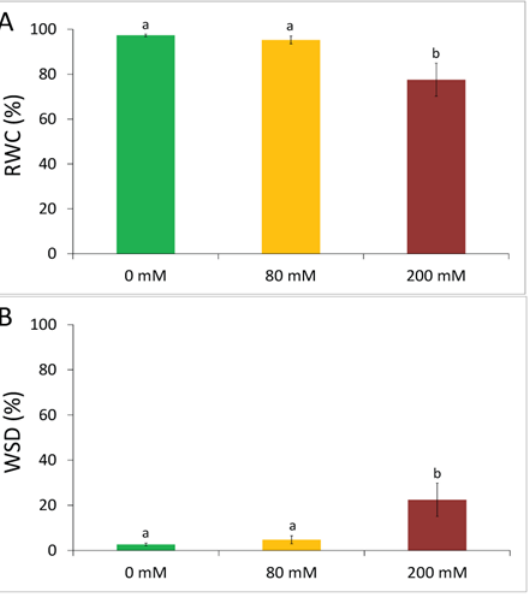
Figure 1. Relative water content (RWC: A ) and water saturation deficit (WSD: B ) recorded in Arundo donax leaves after 1 month of alkaline salt treatment. Error bars represent SD values. To compare the differences, one-way ANOVA was performed on each dataset combined with Tukey’s post-hoc test on the treatments ( p < 0.05). Different lowercase letters indicate significantly different groups.